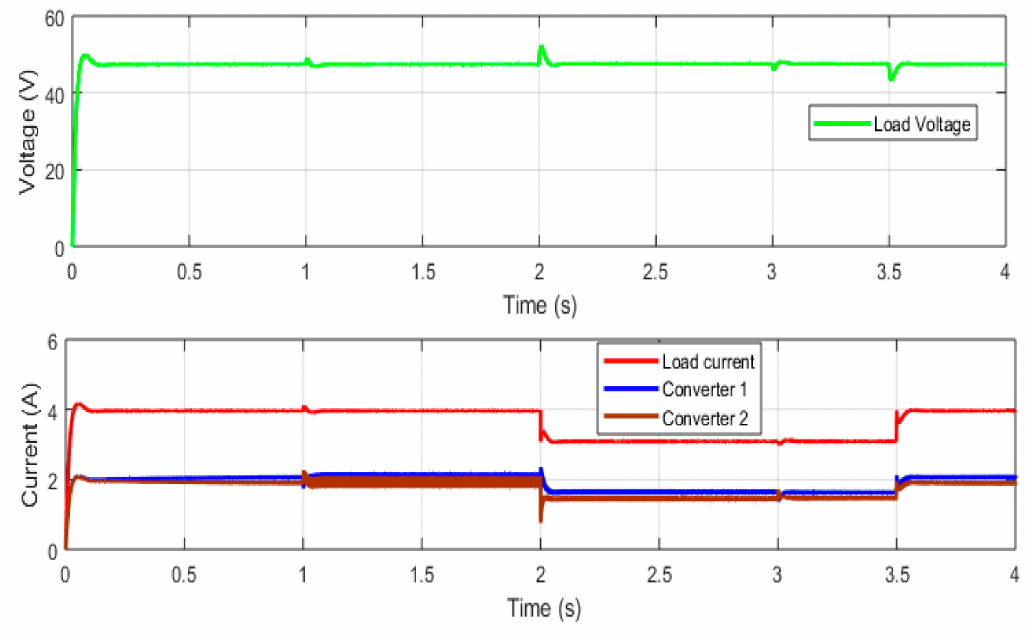
Figure 14. Simulation results for variation in source voltage and load with different cable resistances for proposed droop control: load voltage, converter output currents and load